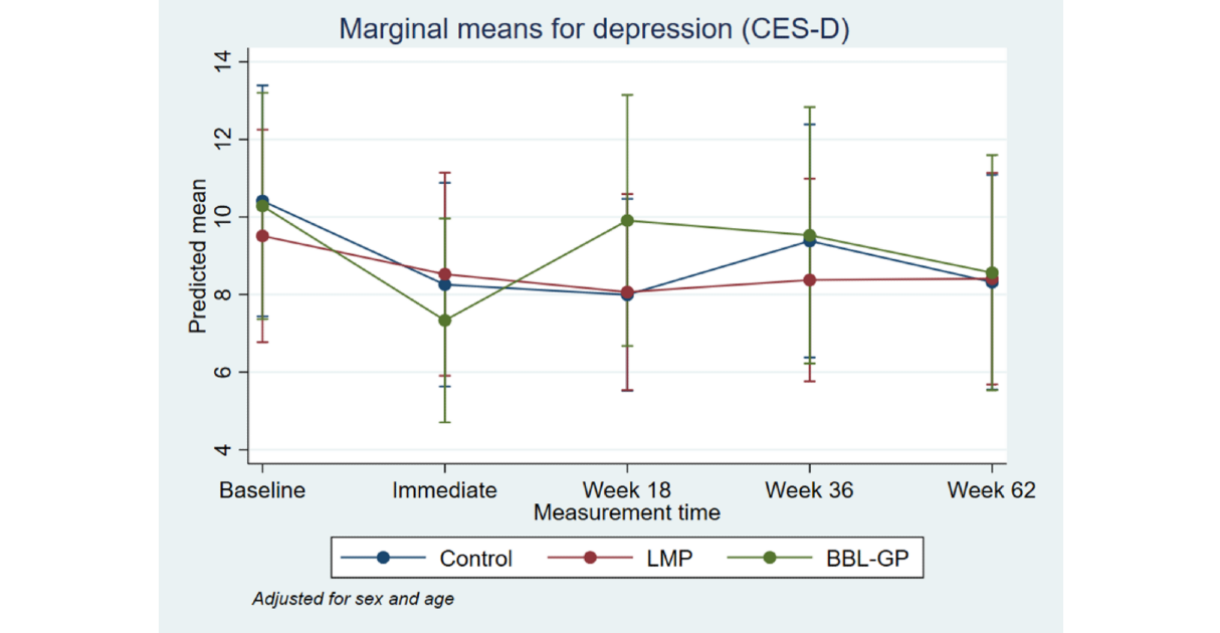
Figure 6. Mean Center for Epidemiological Studies Depression Scale with 95% CI, by time point and intervention group. BBL-GP: Body Brain Life in General Practice; CES-D: Center for Epidemiological Studies Depression Scale; LMP: Lifestyle Modification Program.